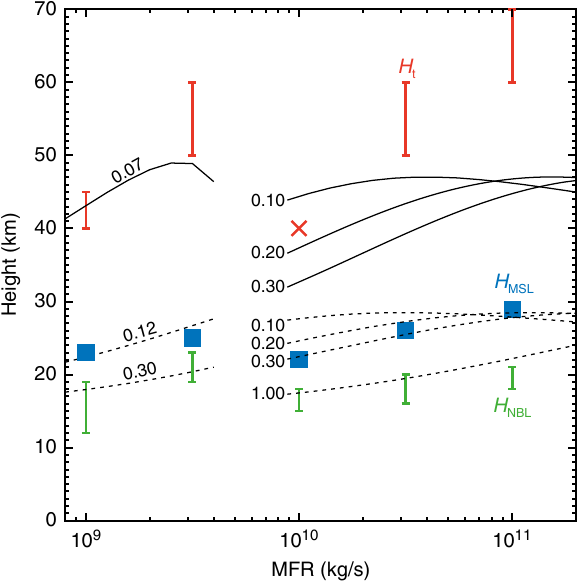
Fig. 3 Characteristic plume heights as a function of the MFR. Red bars represent the height over the whole plume ( H t ). Blue squares represent the altitude of maximum level of radial spreading of the umbrella cloud ( H MSL ). Green bars represent the altitude of NBL ( H NBL ). The characteristic heights from the BPT model are shown as dashed and solid curves. In this diagram, the total heights are compared with the heights where the upward velocity becomes zero in the BPT calculations, whereas the MSLs and NBLs are compared with the NBL calculated by the BPT model (see also Table 2). Values on the curves are the effective entrainment coef fi cients that explain the 3D results. In the calculations of co-ignimbrite ash clouds (the MFR > 10 10 kg/s) using the BPT model, the initial temperature and mass fraction of the entrained air were estimated so that the initial density is equal to the atmospheric density near the ground (see Table 3). According to this mass fraction, the effective MFR at the ground can be estimated. The initial radii were calculated using the scaling law reported in Fig. 2 Here, we focus on the dependence of maximum plume height with MFR (Fig. 3 and Fig. 4 for the dynamics of umbrella cloud). The result shows that from 10 9 to 10 10 kg/s the maximum plume heights remain similar and are between 40 and 60 km. Co-